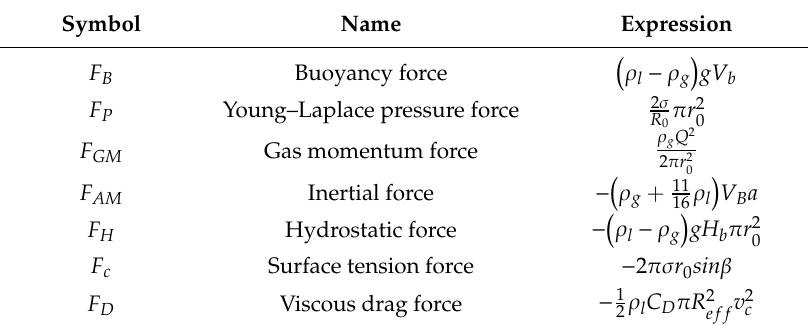
Table 3. List of forces.